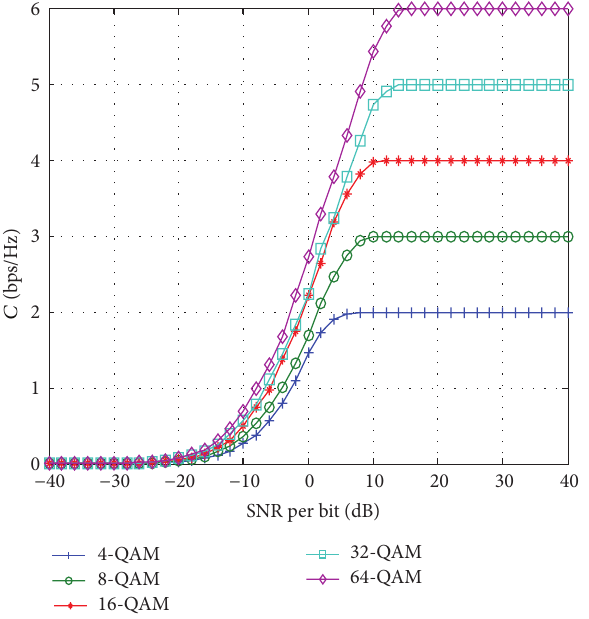
Figure 3: Channel capacity of 𝑀 -ary QAM system over AGWN channels.